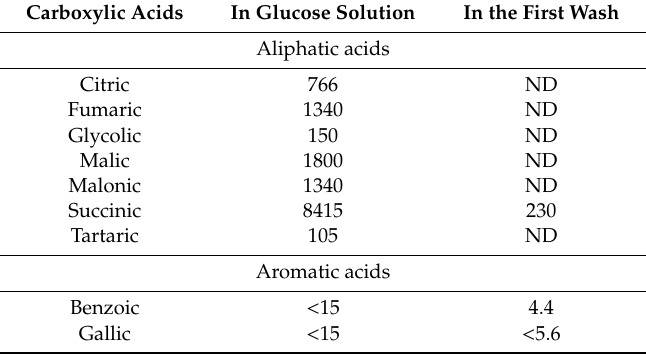
Table 5. Carboxylic acids (mg kg − 1 spores, n = 1) released by unwashed and non-germinated spores of S. rugoso-annulata (6.7 g L − 1 ) in glucose solution pH 2.71 within 60 h (rest glucose, 4.7 g L − 1 ) and into a pool of five first washing fluids.